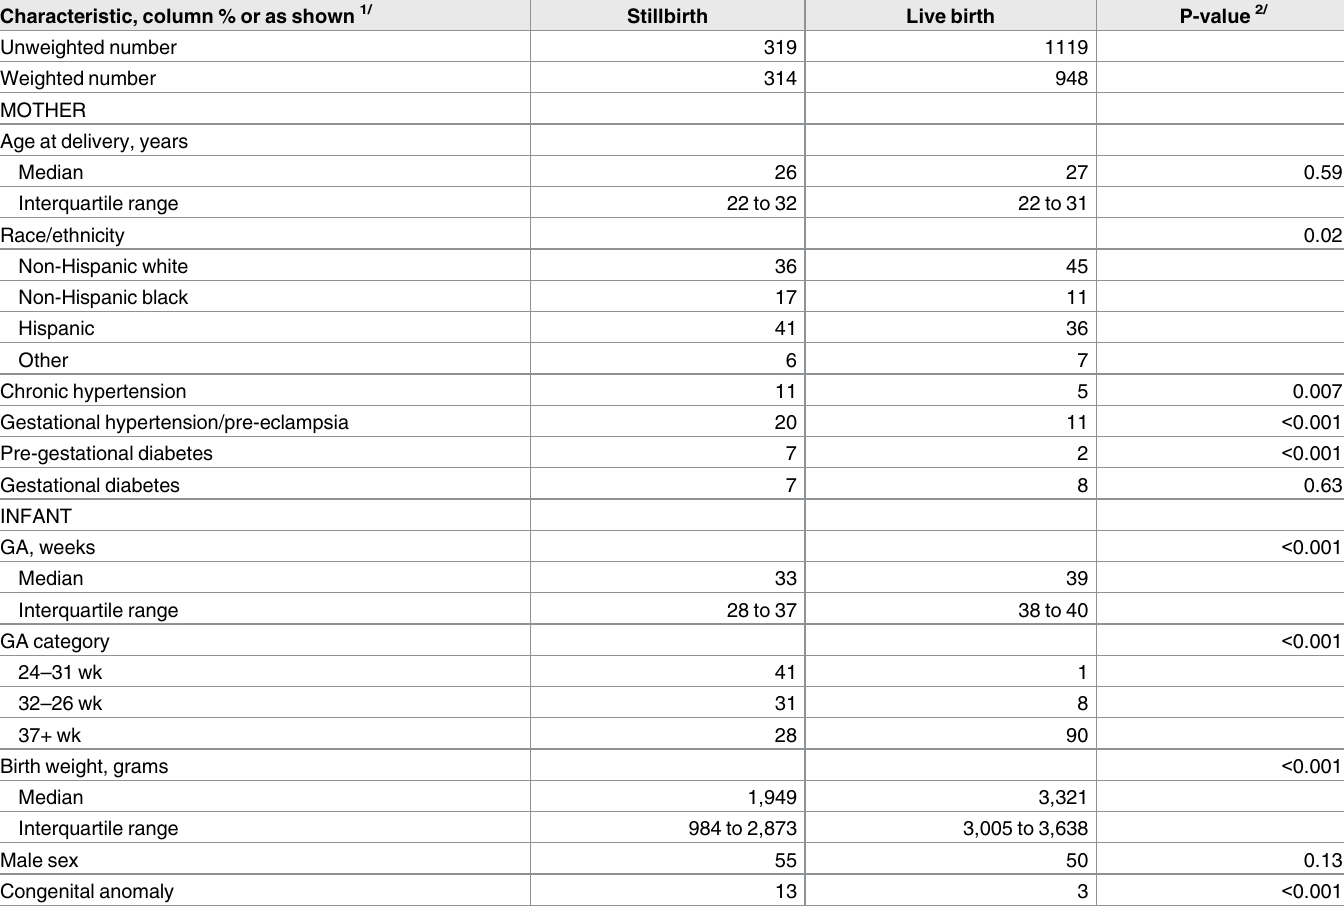
Table 2. Characteristics of singleton stillbirths and live births (cid:21) 24 weeks GA with adequate placental examination. Characteristic, column % or as shown 1/